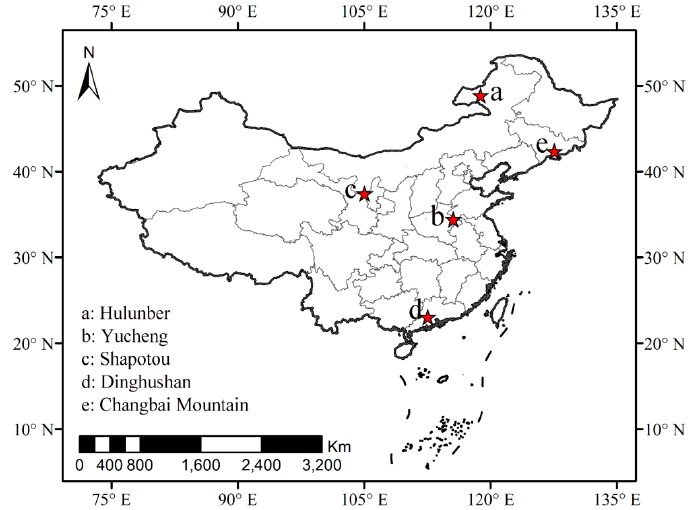
Figure 1. The insets a, b, c, d, and e represent sample locations in different parts of the country.